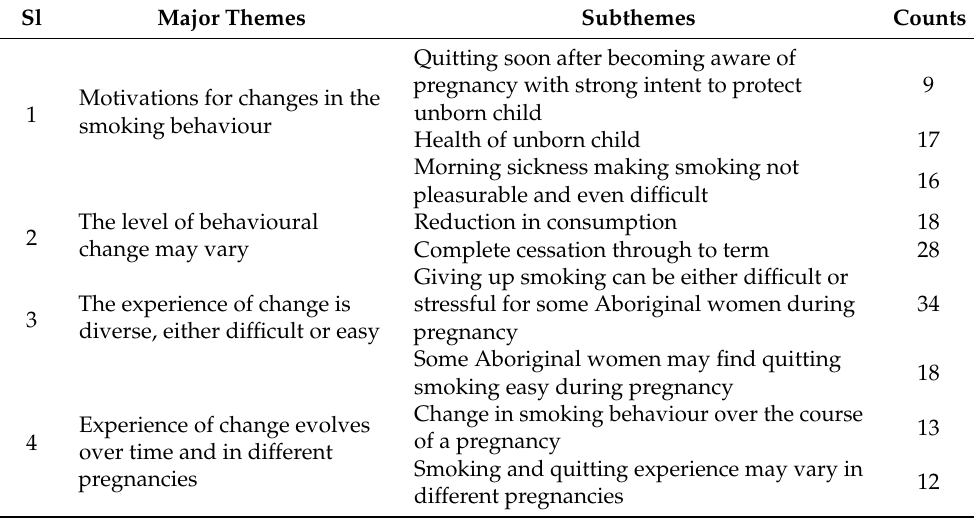
Table 4. Major themes around changes in smoking behaviour in the context of